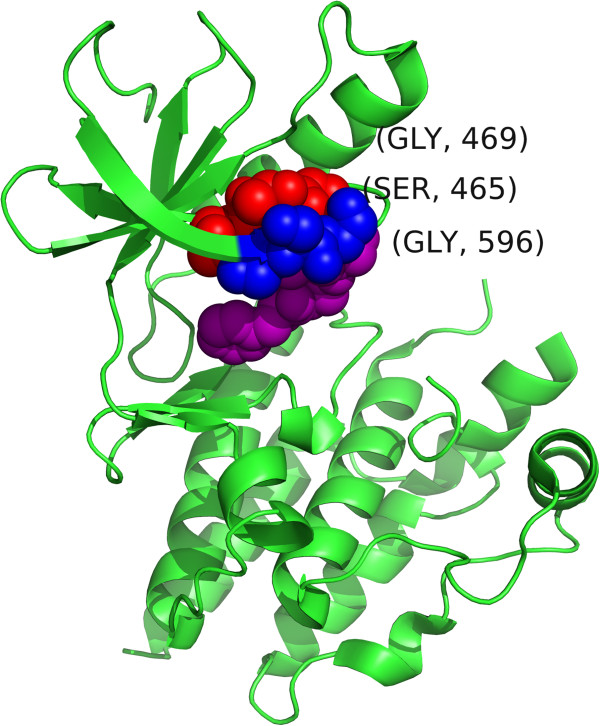
BRAF clustering. The BRAF structure (PDB ID: 3Q96) where cluster 464-466 is shown in blue, 469-471 is shown in red and 595-597 is shown in purple. The central residue in each cluster (465, 470 and 596 for the blue, red and purple clusters, respectively) is labeled.